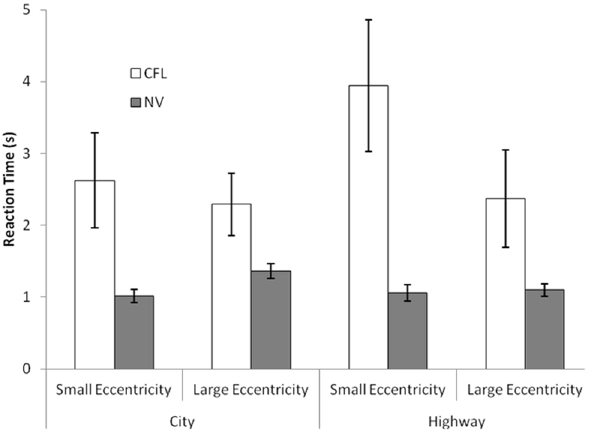
bars represent 95% confidence interval.